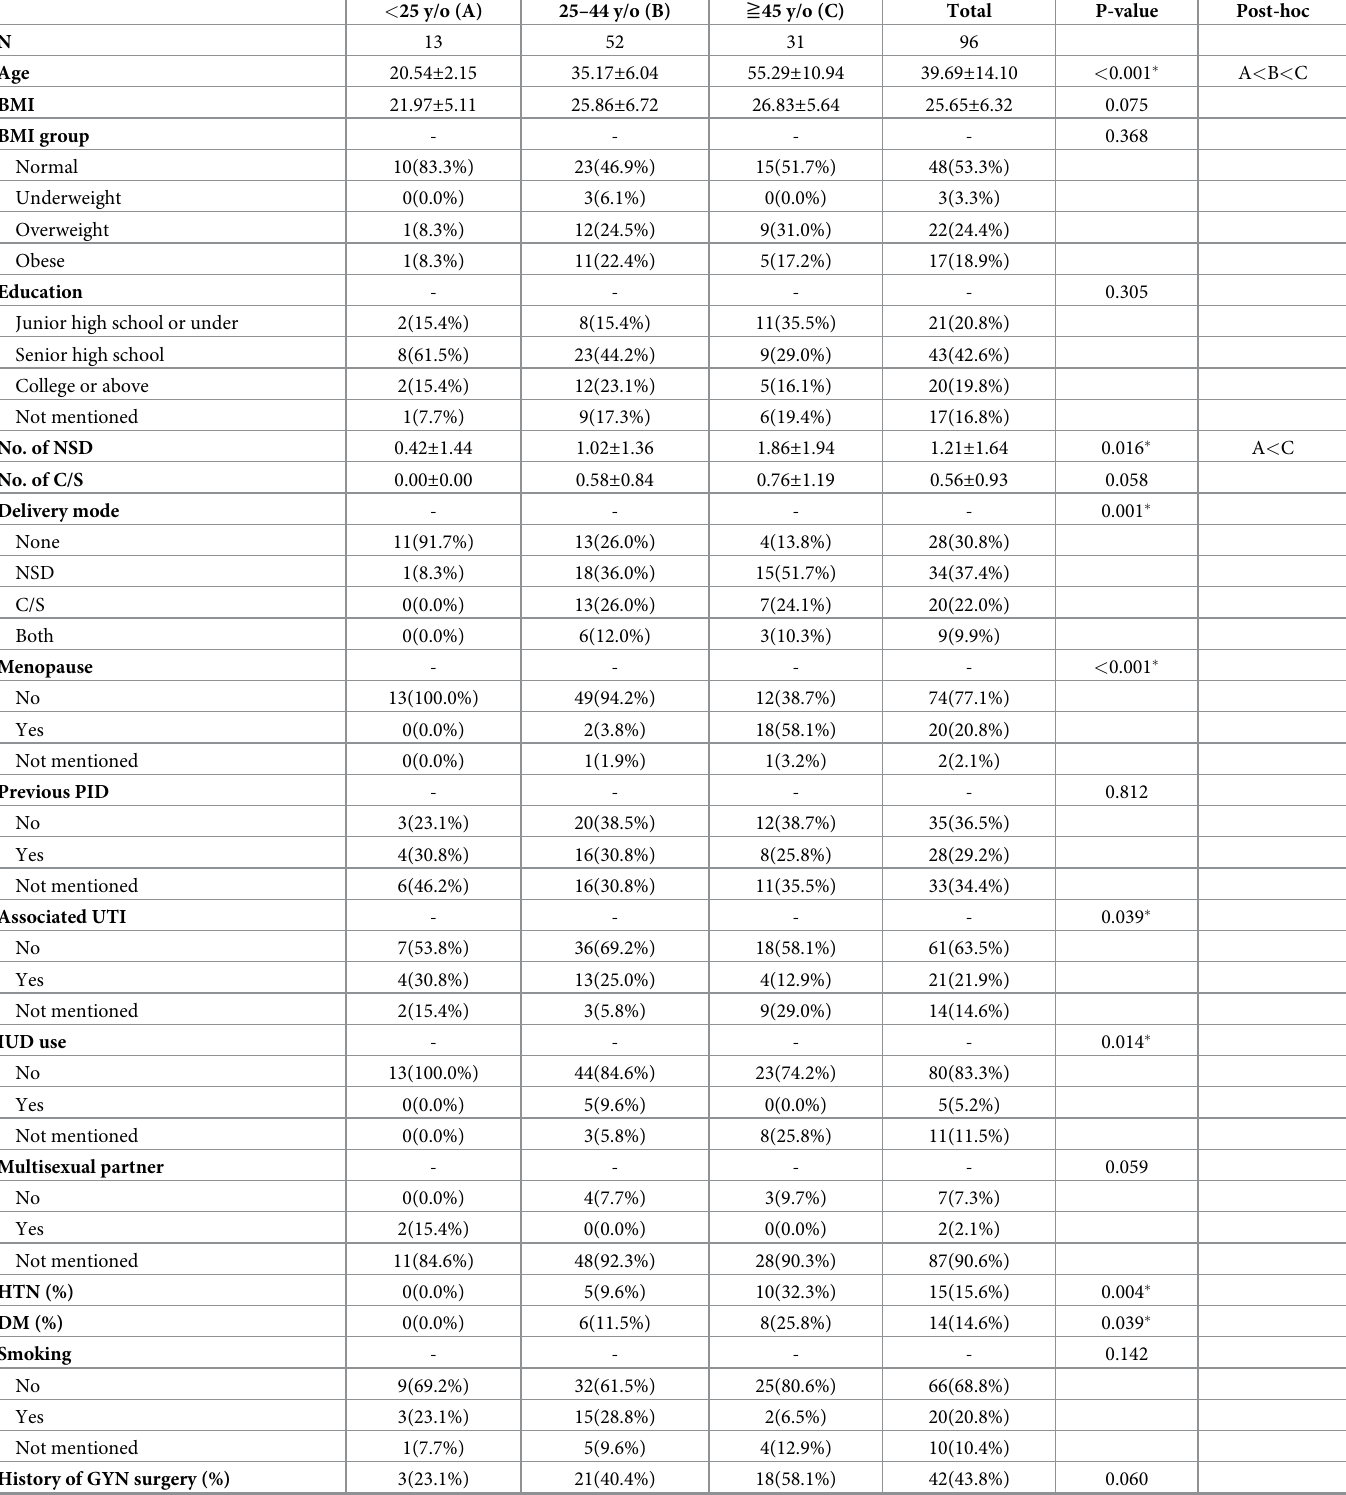
Table 1. Demographics (n =